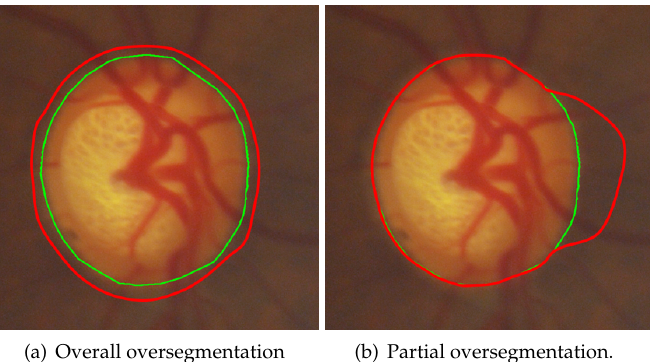
Figure 21. Limitations of IoU evaluation methods, (green contour: GT, red contour: hypothetical segmentation